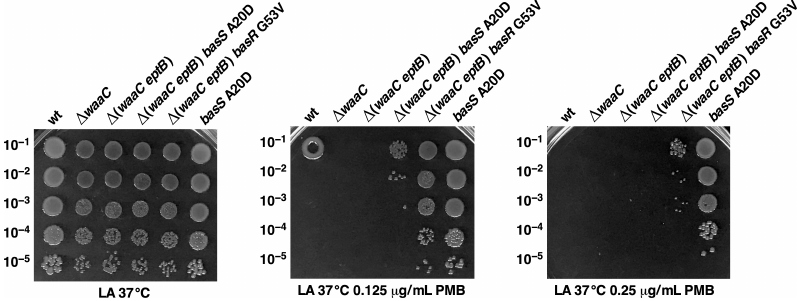
Figure 11. Suppressor mutations in either the basS or basR genes confer polymyxin B resistance. Exponentially grown cultures of the wild type, its isogenic derivatives in the absence of the waaC gene, ∆ ( waaC eptB ) , and its derivatives with the suppressor mutation in either the basS or the basR genes, were adjusted to an OD 595 of 0.1 and serially spot diluted at 37 ◦ C, either in in LA agar alone, or supplemented with either 0.125 µ g/mL or 0.25 µ g/mL of polymyxin B. Additionally, the culture of wild-type strain carrying basS A20D is included (last lane). Plates were incubated for 24 h, and the data presented are from one of the representative experiments. Note polymyxin B resistance when the suppressor mutation mapping to either the basS or basR genes is present.